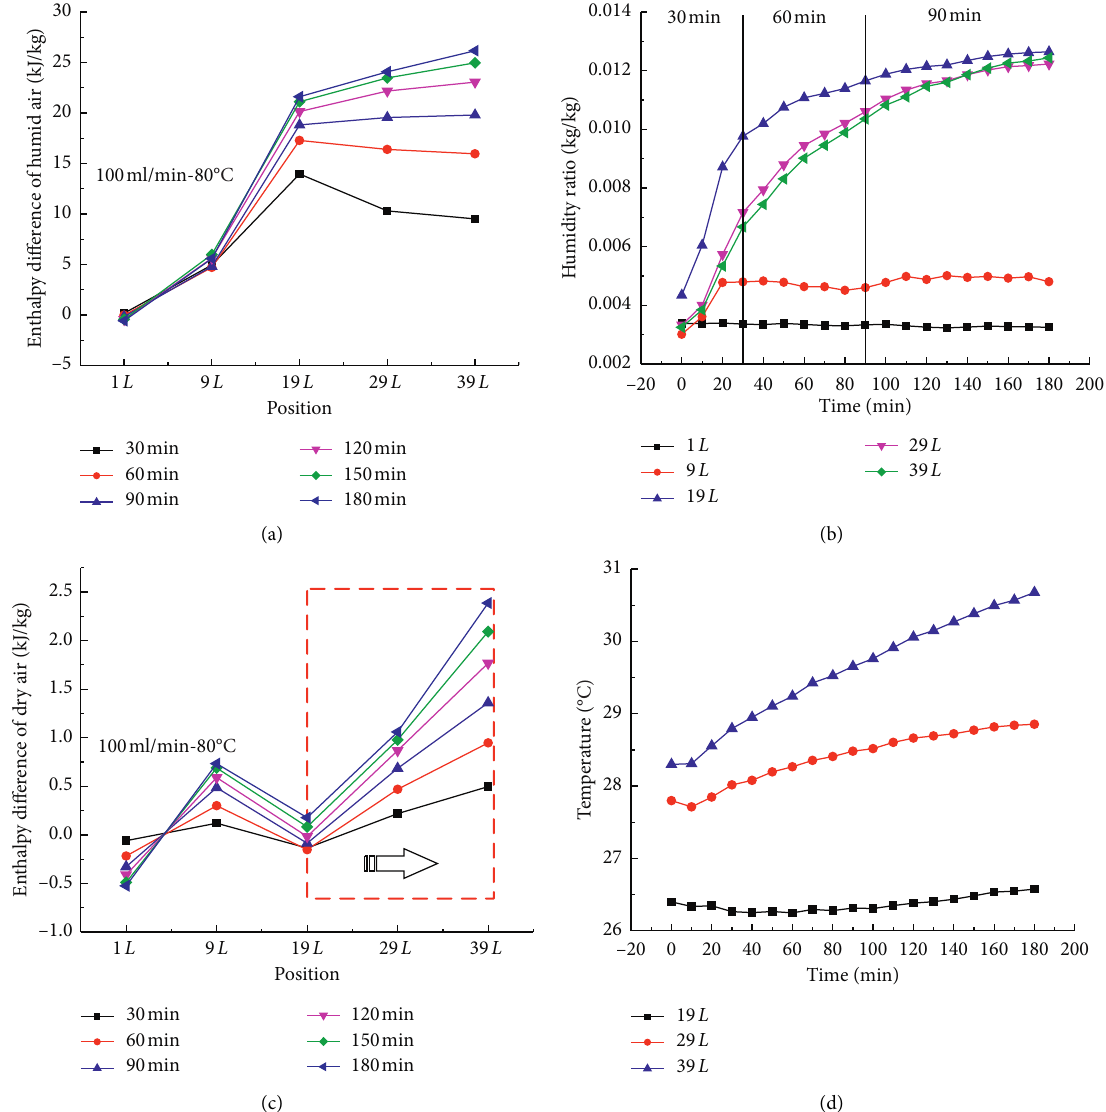
Figure 9: Analysis of the enthalpy difference variations at 19 L , 29 L , and 39 L under the condition of